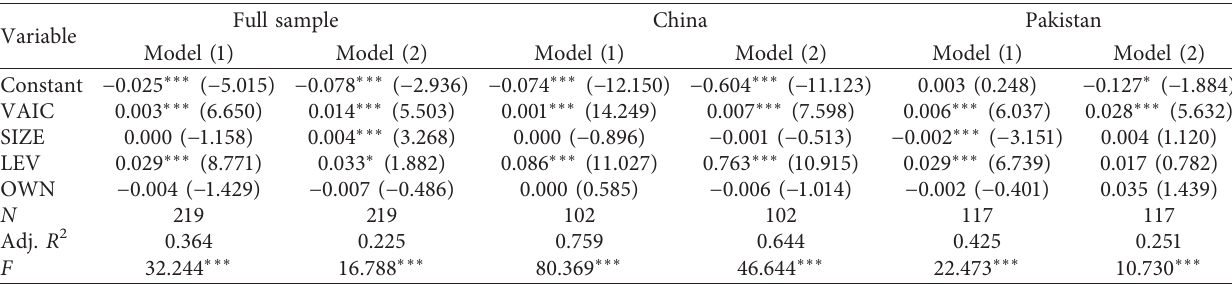
Table 3: Regression results of Models (1) and (2).